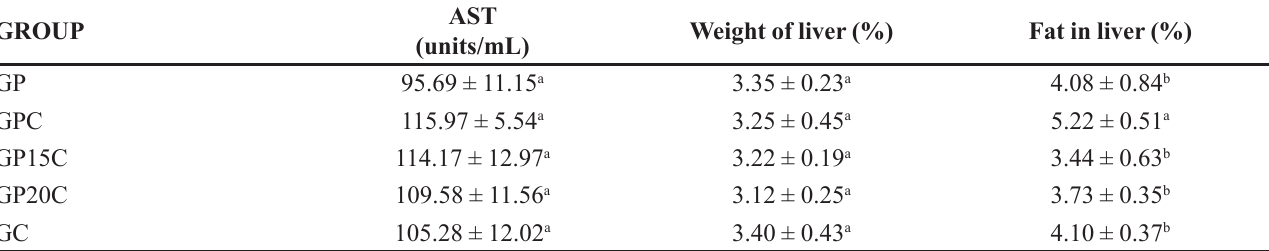
GP - diet with bread; GPC - diet with bread and cholesterol; GP15C - diet with 15% quinoa bread and cholesterol; GP20C - diet with 20% quinoa bread and cholesterol; GC - diet with cholesterol. Values in the same column with different letters indicate a statistically significant difference between the means by the Tukey test (p ≤ 0.05).